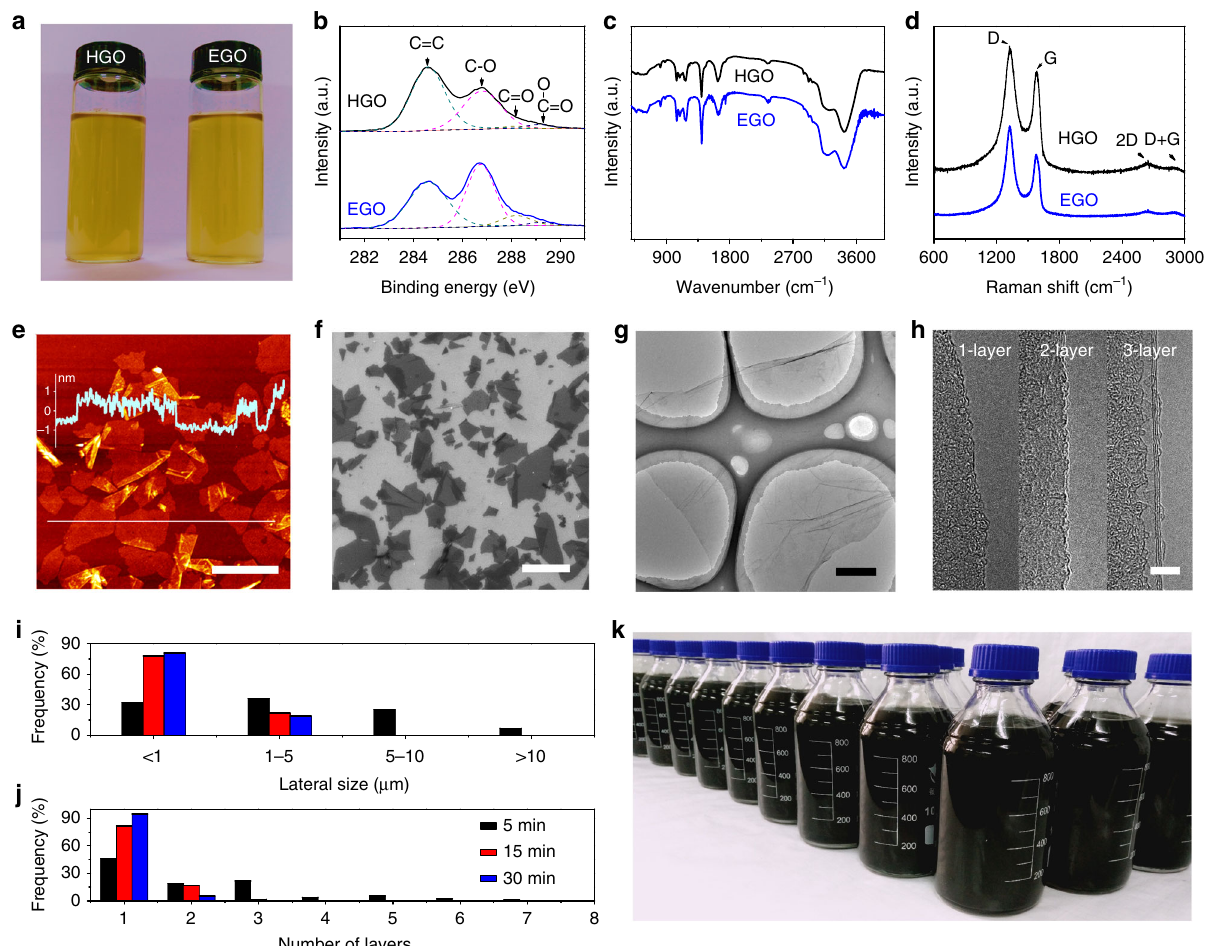
Fig. 2 Characterization of EGO. a-d , Comparison of EGO with HGO: aqueous solution ( a , 1 mg · mL -1 ), XPS C1s spectra ( b ), FTIR spectra ( c ), Raman spectra ( d ). HGO was synthesized by a modi fi ed Hummers method 7 using graphite fl akes (80 mesh) as raw material. e – h , Typical AFM ( e ), SEM ( f ), TEM ( g ), and HRTEM ( h ) images of EGO sheets. i , j , Lateral size ( i ), and number of layers ( j ) distribution of EGO sheets obtained by sonication for 5 (black columns), 15 (red columns), and 30 min (blue columns). k , Mass produced EGO aqueous solution (5 mg · mL − 1 ). Scale bars: e , 2 μ m; f , 10 μ m; g , 1 μ m; h , 5